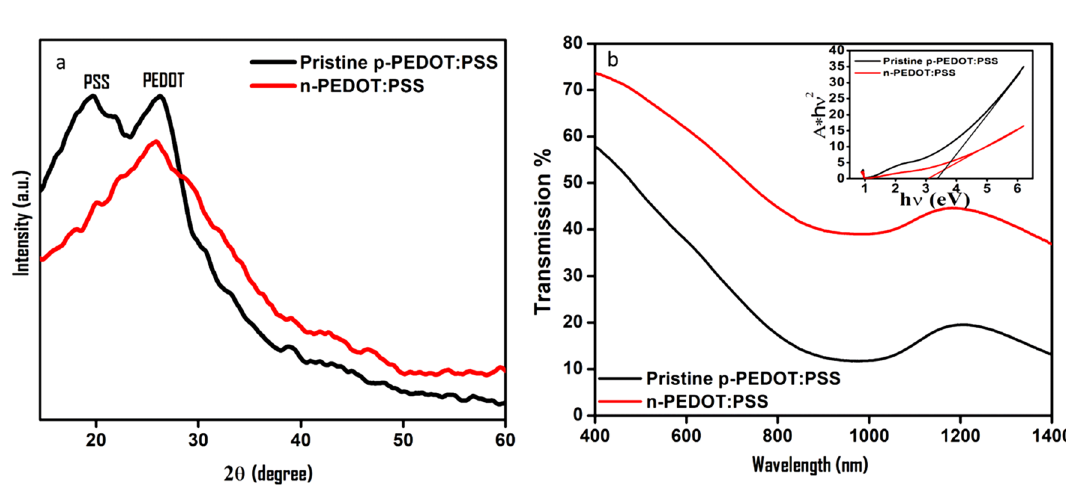
Figure 2. ( a ) XRD pattern and ( b ) transmittance spectra of pristine and PEDOT:PSS/ISO films. The insets show the estimated